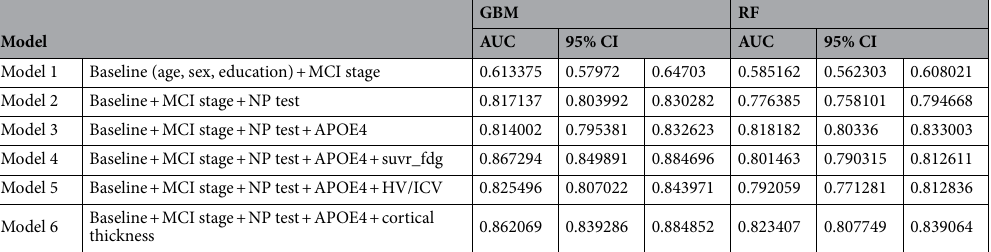
Table 2. ML models with different combinations of biomarkers using the total dataset. AUC Area under the curve, MCI mild cognitive impairment, APOE4 Apolipoprotein E 4 genotype, NP Neuropsychological, GBM